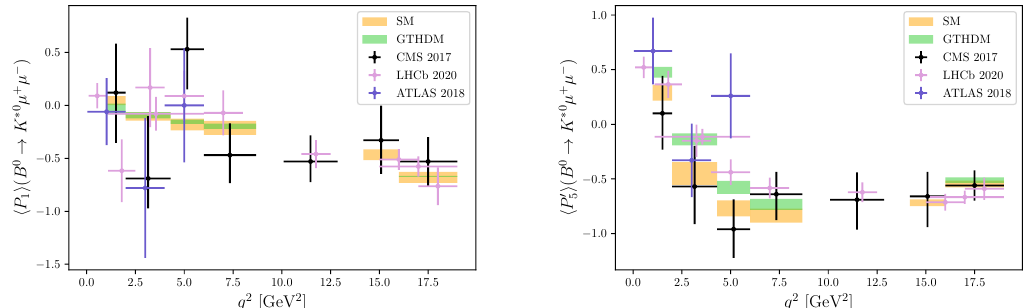
Figure 10 . Predicted distributions for Left : h P 1 i and Right : h P 0 i compared to the CMS 2017 [186], 5 ATLAS 2018 [187] and LHCb 2020 [188] data. The theoretical uncertainties using GAMBIT have been computed assuming a symmetric Gaussian distribution for the resulting one-dimensional profile likelihoods for each one of the bins. The theory predictions close to the J/ψ (1 S ) and ψ (2 S ) narrow charmonium resonances are vetoed from all our plots.